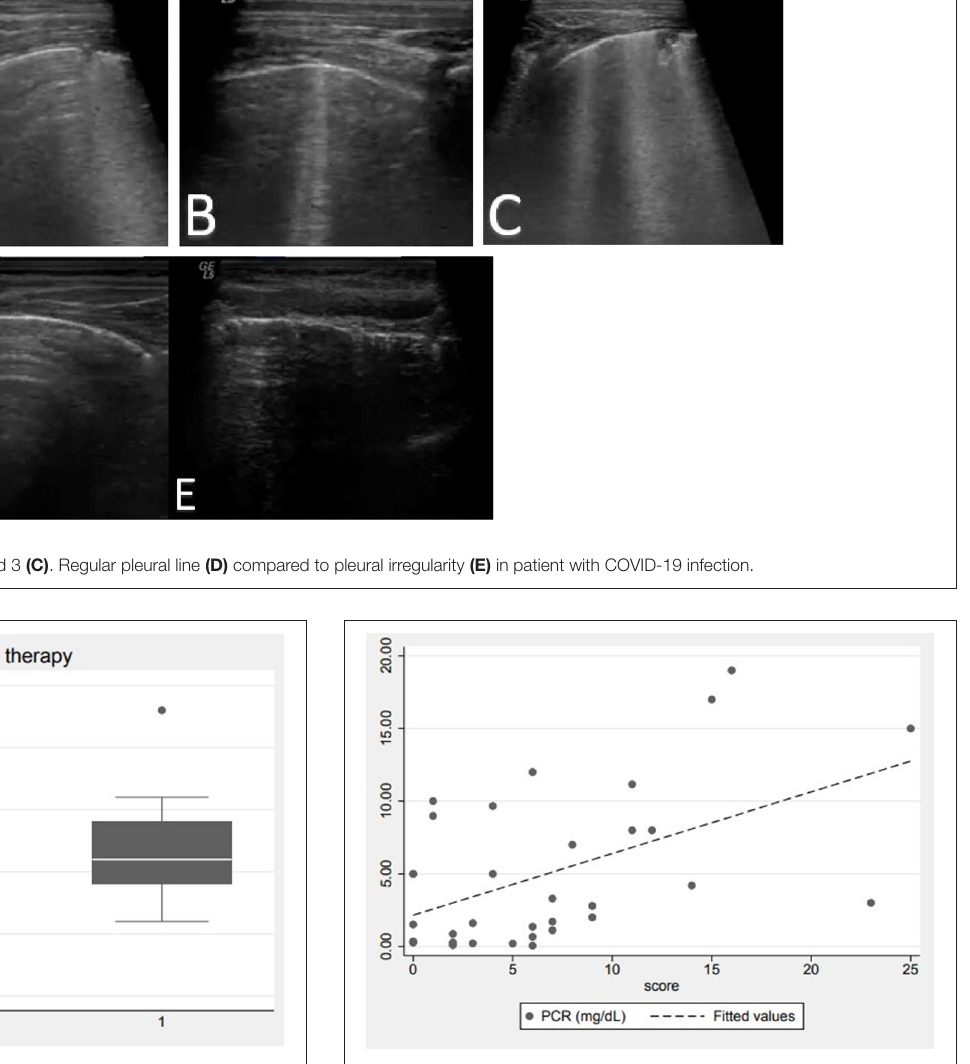
SARS-CoV-2 infection (mean value 9 vs. 4, with an SD of 6.8 and 3.5, respectively, p = 0.03). Pleural effusion was found